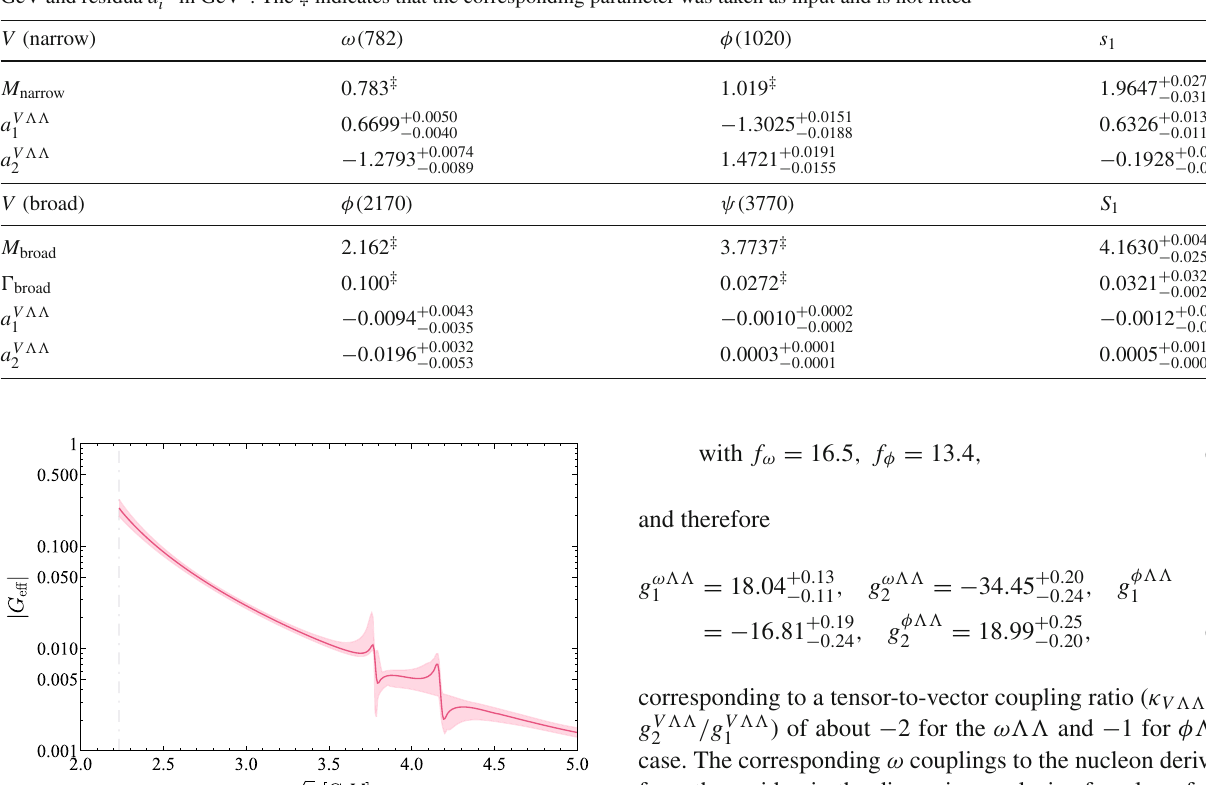
Table 2 The parameters corresponding to our best fit (Fit-II) together with the bootstrap errors. Masses M V and widths (cid:13) V are given in units of GeV and residua a V in GeV 2 . The ‡ indicates that the corresponding parameter was taken as input and is not fitted i